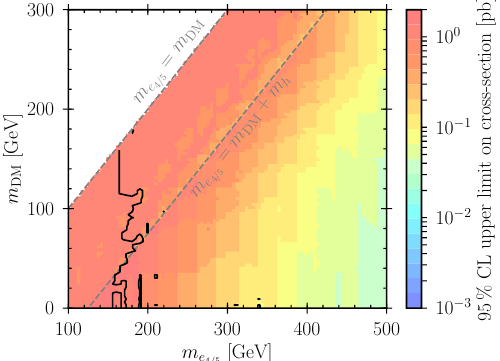
Figure 13 . Cross section for pp lepton mass. The colors resemble the color-coding of the cross section in reference [77].